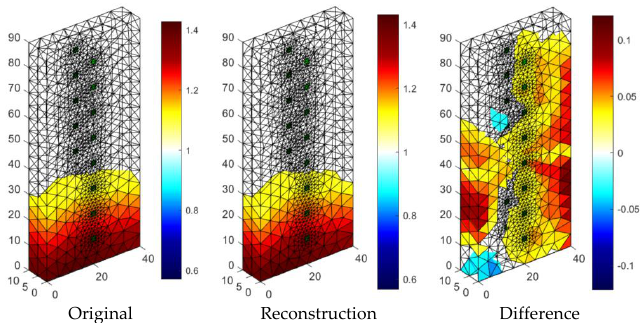
Figure 15. The result of Least Angle Regression (LARS) moisture testing of the lightweight concrete block for the case of 2 × 8 electrodes.